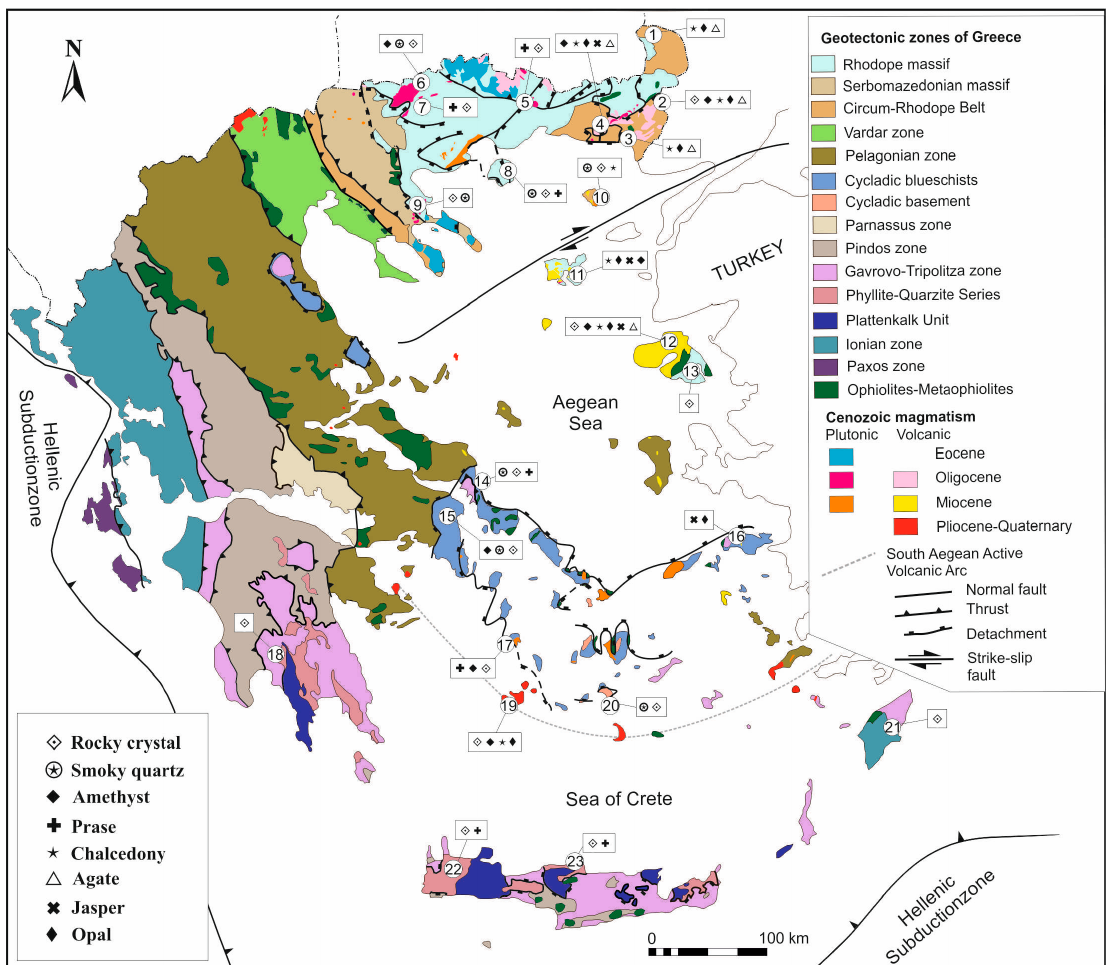
Figure 2. Occurrences of gem-quality silica varieties in metamorphic and igneous rocks of Greece (Geological map of Greece modified after Ottens and Voudouris [17]): 1. Dikea/Evros, 2. Kornofolia/Evros, 3. Aetochori/Evros 4. Sapes/Rhodopi, 5. Kimmeria/Xanthi, 6. Dassoto/Drama, 7. Cresti/Drama, 8. Trikorfo/Thassos, 9. Stratoni-Olympiada/Chalkidiki, 10. Fengari/Samothraki, 11. Moudros-Roussopouli/Limnos Island, 12. Megala Therma/Lesvos Island, 13. Geras/Lesvos, 14. Krieza-Koskina/Evia Island, 15. Penteli Mt/Attika, 16. Ampelos/Samos Island, 17. Avessalos/Serifos Island, 18 Taygetos,. 19. Chondro Vouno-Vani/Milos Island, 20. Mylopotas/Ios Island, 21. Rhodes Island, 22. Prases/Crete Island, 23. Agia Pelagia/Crete